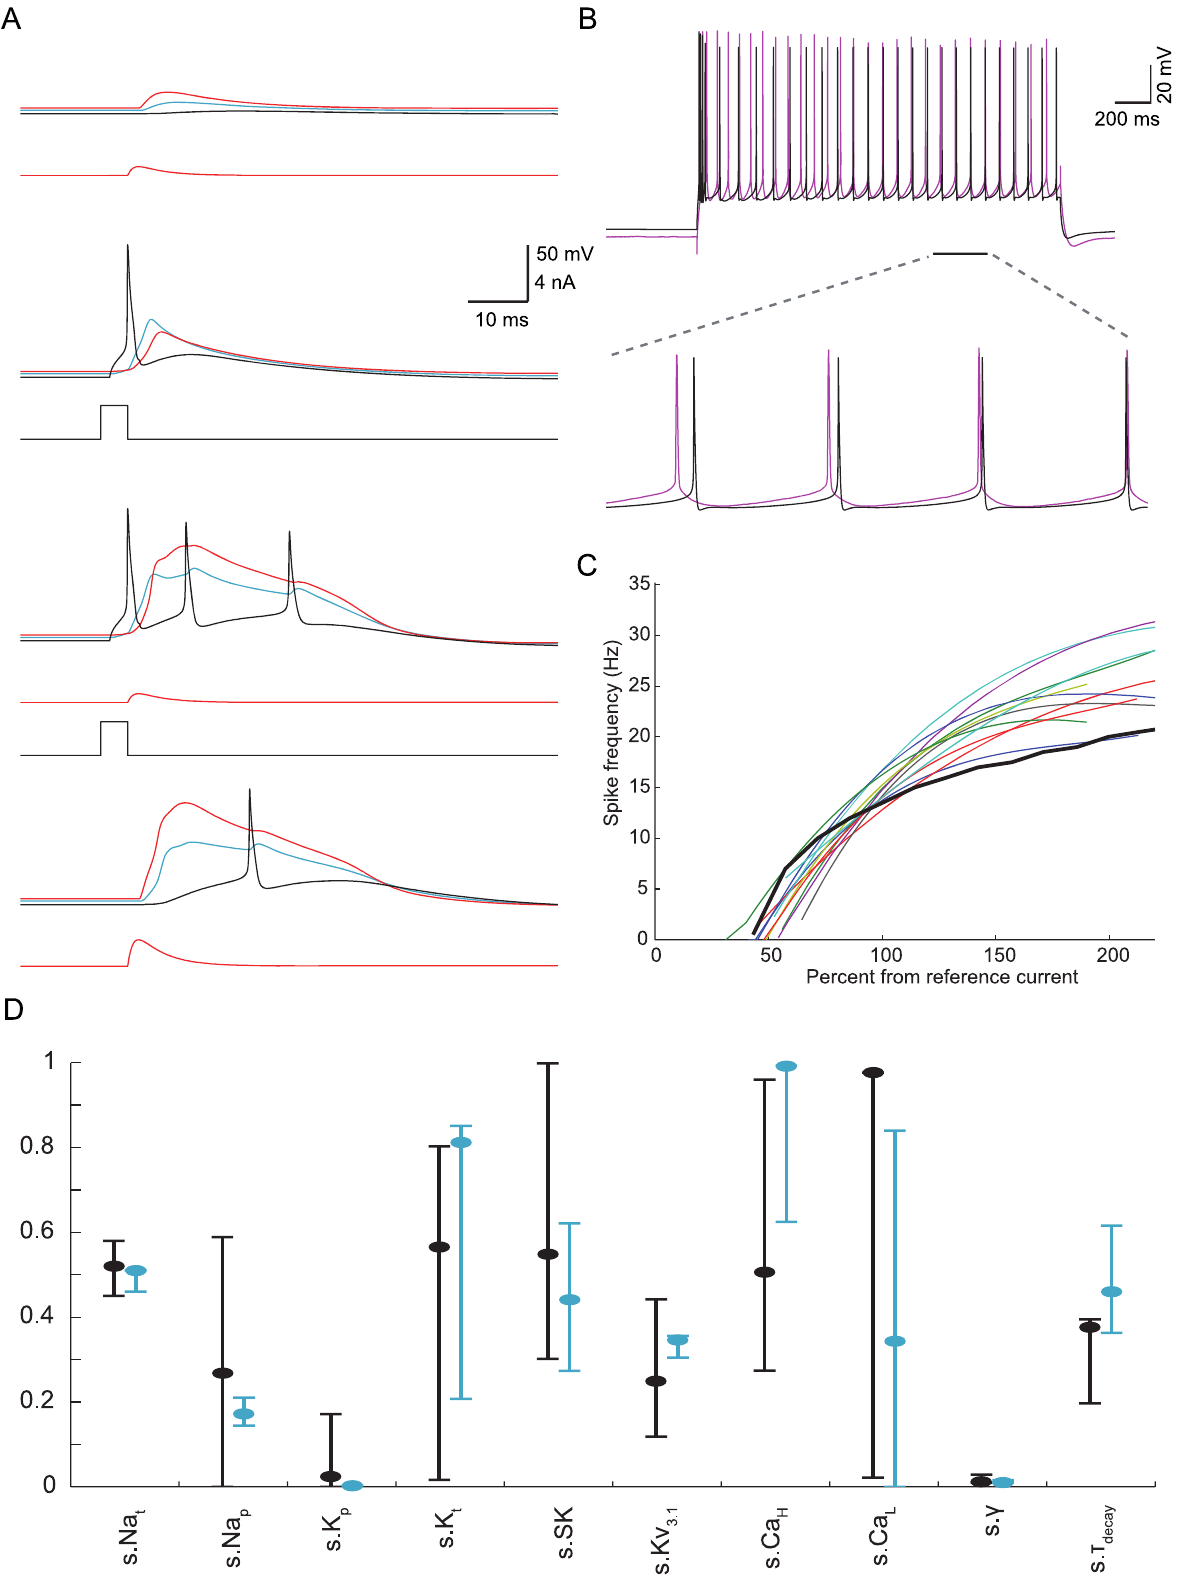
Figure 4. Example of an acceptable model for both BAC firing and perisomatic step current firing. A . The model faithfully reproduced BAC firing (compare to Figure 1B–E). B. Firing response of the same model as in (A) to perisomatic step current injection (black–model, magenta– experiment). C. The model’s f–I curve (black) and experimental f–I curves (colors). All measures and definitions are as described in Figures 1 and 2.